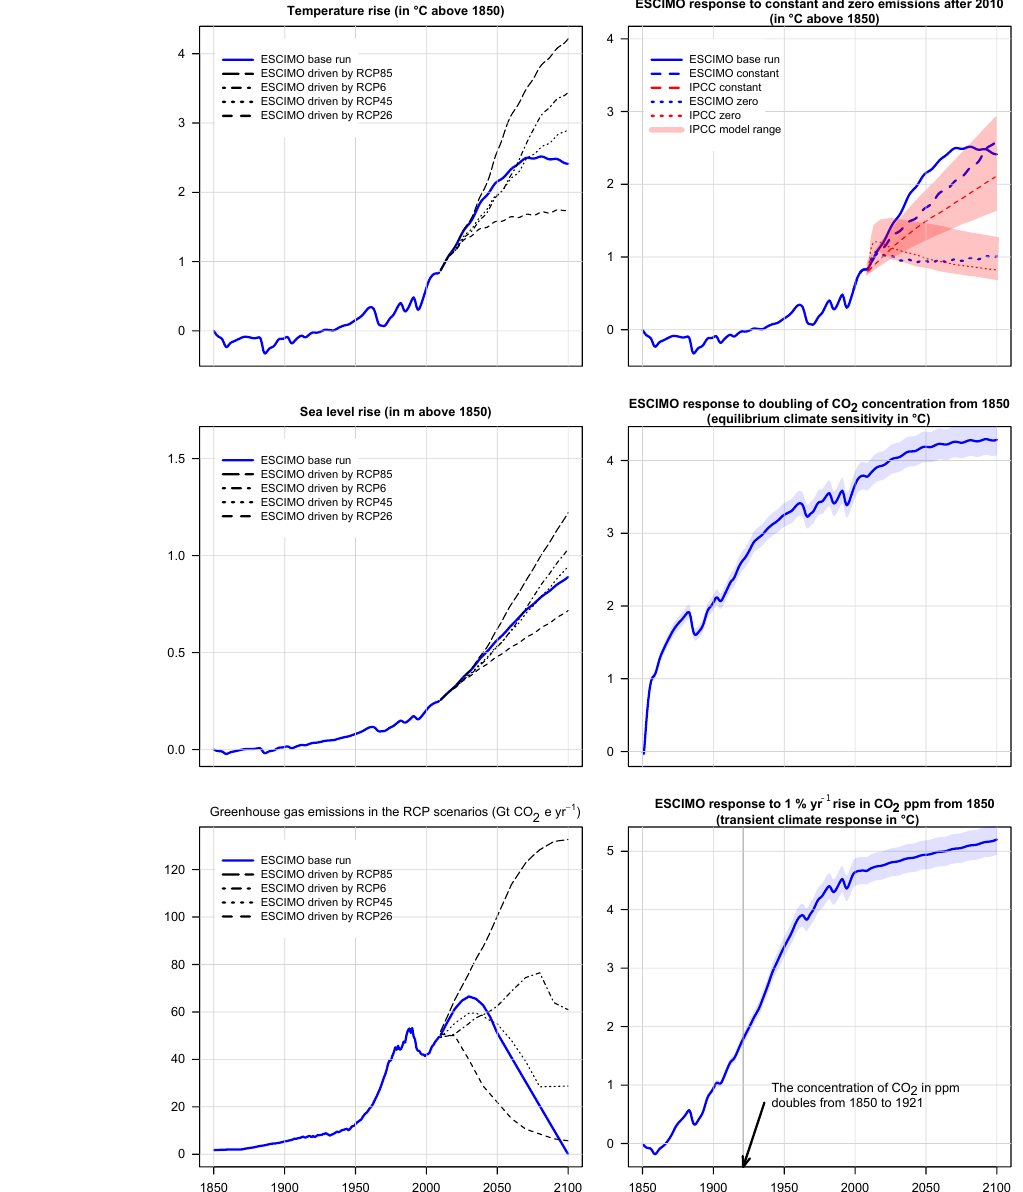
Figure 8. The response in ESCIMO to four RCP emissions scenarios (left panels) and to four other experiments (right panels). All compared to the ESCIMO base run (blue). All changes introduced in 2015. World 1850 to 2100.